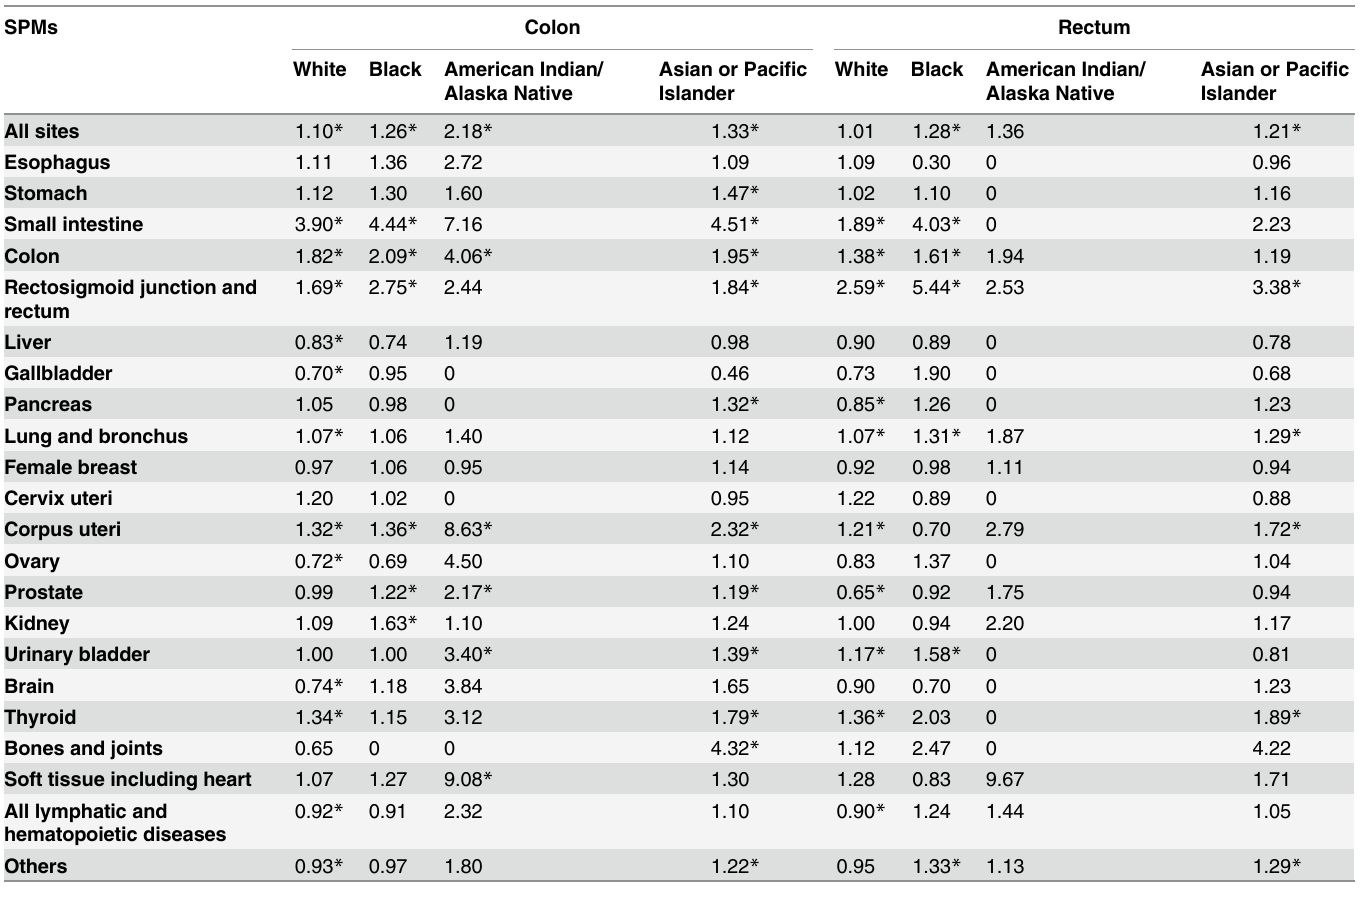
Table 4. SIRs of SPMs in colon and rectal cancer patients, by race.